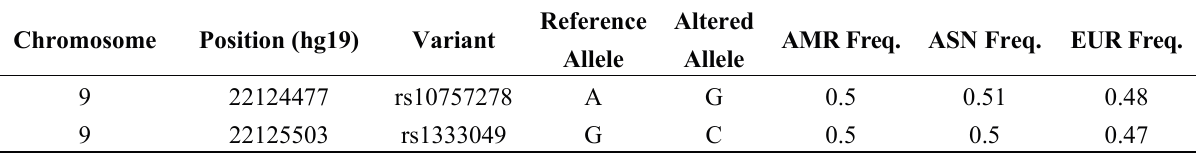
Table 2. The selected studies investigating the association between rs10757278 and MI. Chromosome Position (hg19) Variant